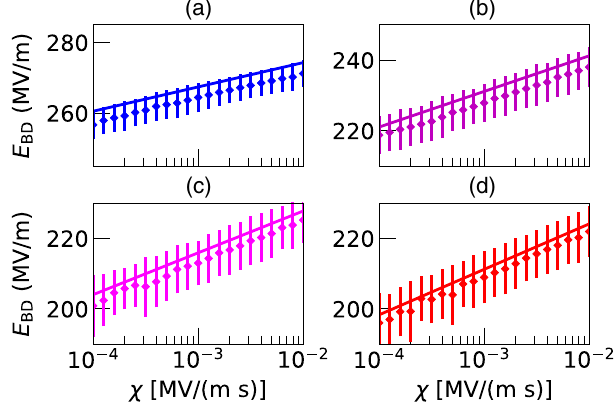
FIG. 16. Mean breakdown field as a function of the field increase rate for a linearly incrementing field, calculated using the metastable approximation [Eqs. (18) and (26), solid line] and the simulation (squares with error bars), for temperatures of (a) 100, (b) 200, (c) 300, and (d) 400